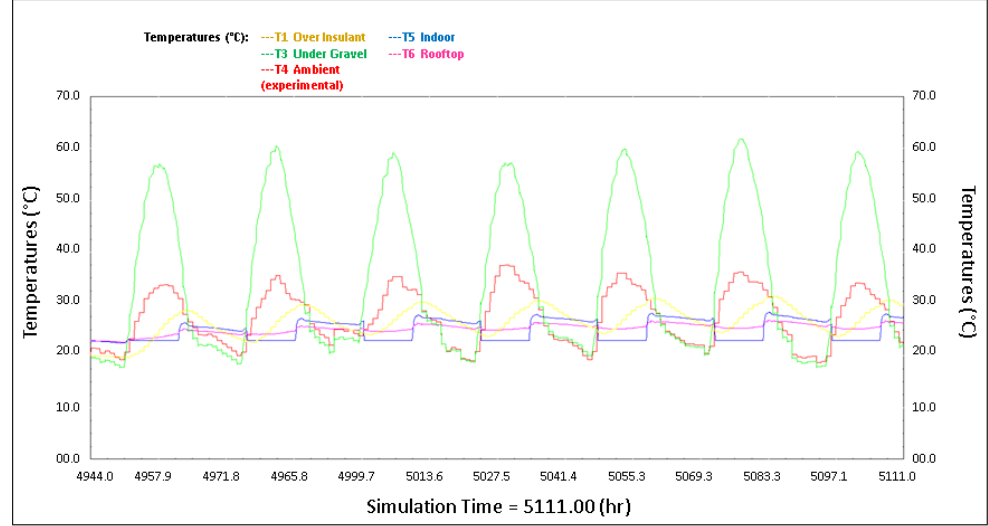
Figure 14. Simulated temperatures of the initial rooftop.